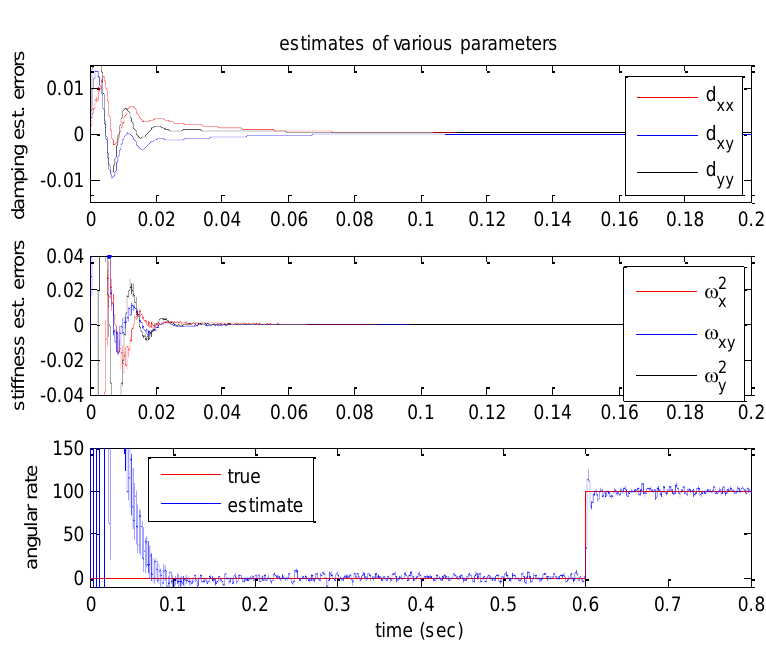
Figure 4. Time response of parameter